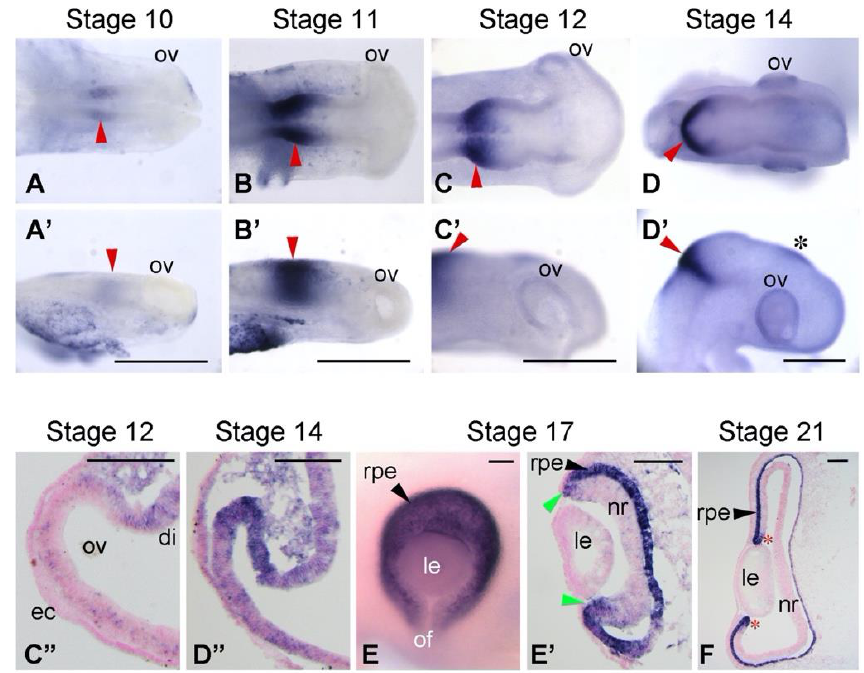
Figure 1. Expression pattern of BHLHE40 in chicken early embryos. ( A – D’ , E ) Whole-mount in situ hybridization of chick embryos at Hamburger and Hamilton (HH) stages 10 to 14, and 17. Dorsal views ( A – D ) and lateral views ( A’ – D’ ; to the same scale of A – D , respectively) of embryonic heads or eye ( E ) are shown. Red arrowheads show the midbrain-hindbrain boundary. Asterisk in ( D’ ) shows the developing pineal gland. ( C” , D” , E’ , F ) Frontal sections of the optic primordia at stages 12 to 21. Lateral is to the left. Dorsal is to the top. Light green arrowheads in ( E’ ) and asterisks in ( F ) show the ciliary marginal zone. mRNA signals are in dark blue. For sections, cell nuclei were stained with nuclear fast red. di, diencephalon; ec, surface ectoderm; le, lens vesicle; nr, neural retina; of, optic fissure; ov, optic vesicle; rpe, developing RPE. Scale bars: 0.5 mm in ( A – D’ ), 100 µ m ( C” , D” , E , E’ , F